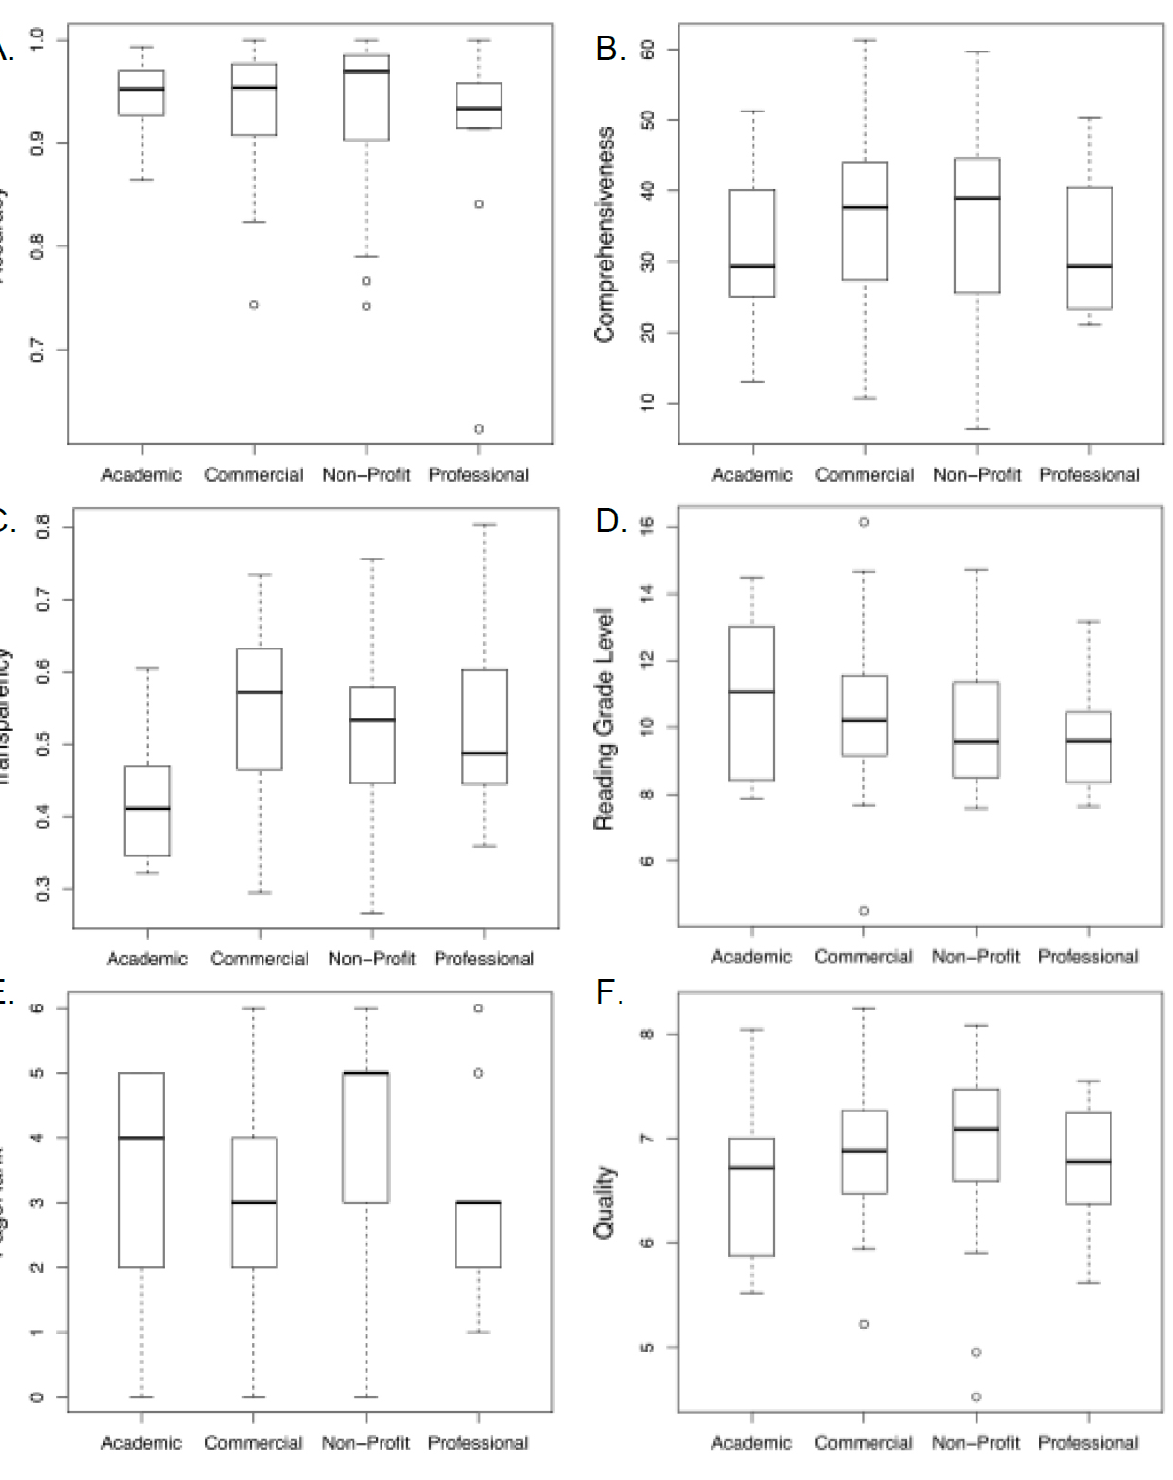
Figure 1. Distribution of accuracy (A), comprehensiveness (B), transparency (C), reading grade level (D), PageRank (E), and quality scores (F) for the studied websites. The bottom and top of the box-and-whisker plots represent the 25th and 75th percentiles (ie, lower and upper quartiles, respectively). Crossbar is the median (50th percentile). Ends of whiskers represent data within 1.5 times the interquartile range of the lower and upper quartiles. Data not included between whiskers are shown as outliers (small circle). Spacing between the parts of the box indicates degree of dispersion and skewness of the data. Panel A, F 3,94 = 0.70; Panel B, F 3,94 = 0.34; Panel C, F 3,94 = 4.07; panel D, F 3,90 = 1.00; panel E, F 3,87 = 2.71; panel F, F 3,94 =